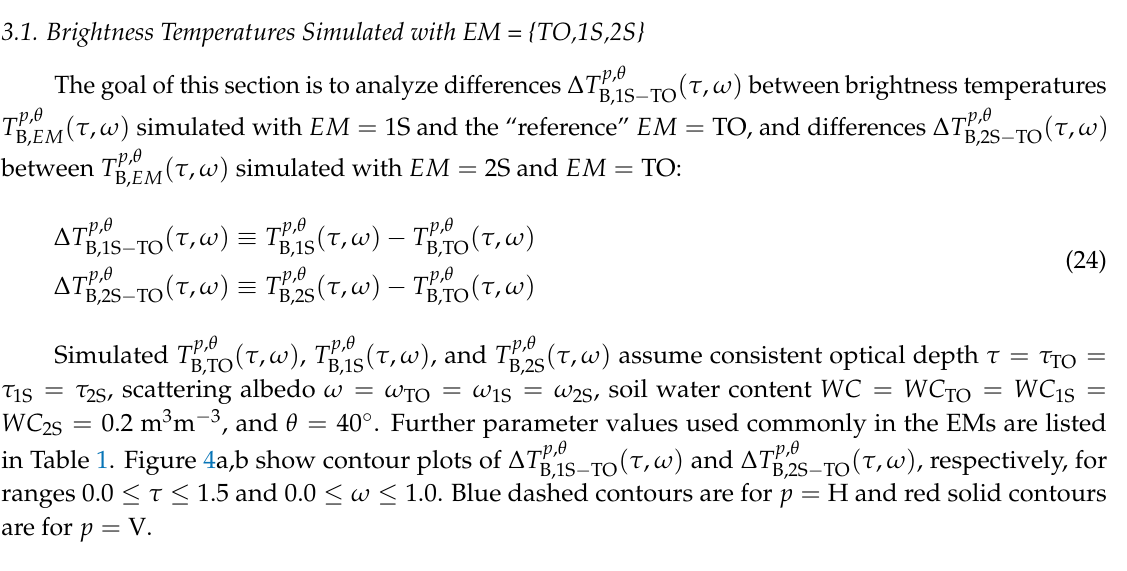
p , θ j (cid:2886)(cid:3043),(cid:3087) (cid:3285) measured at B